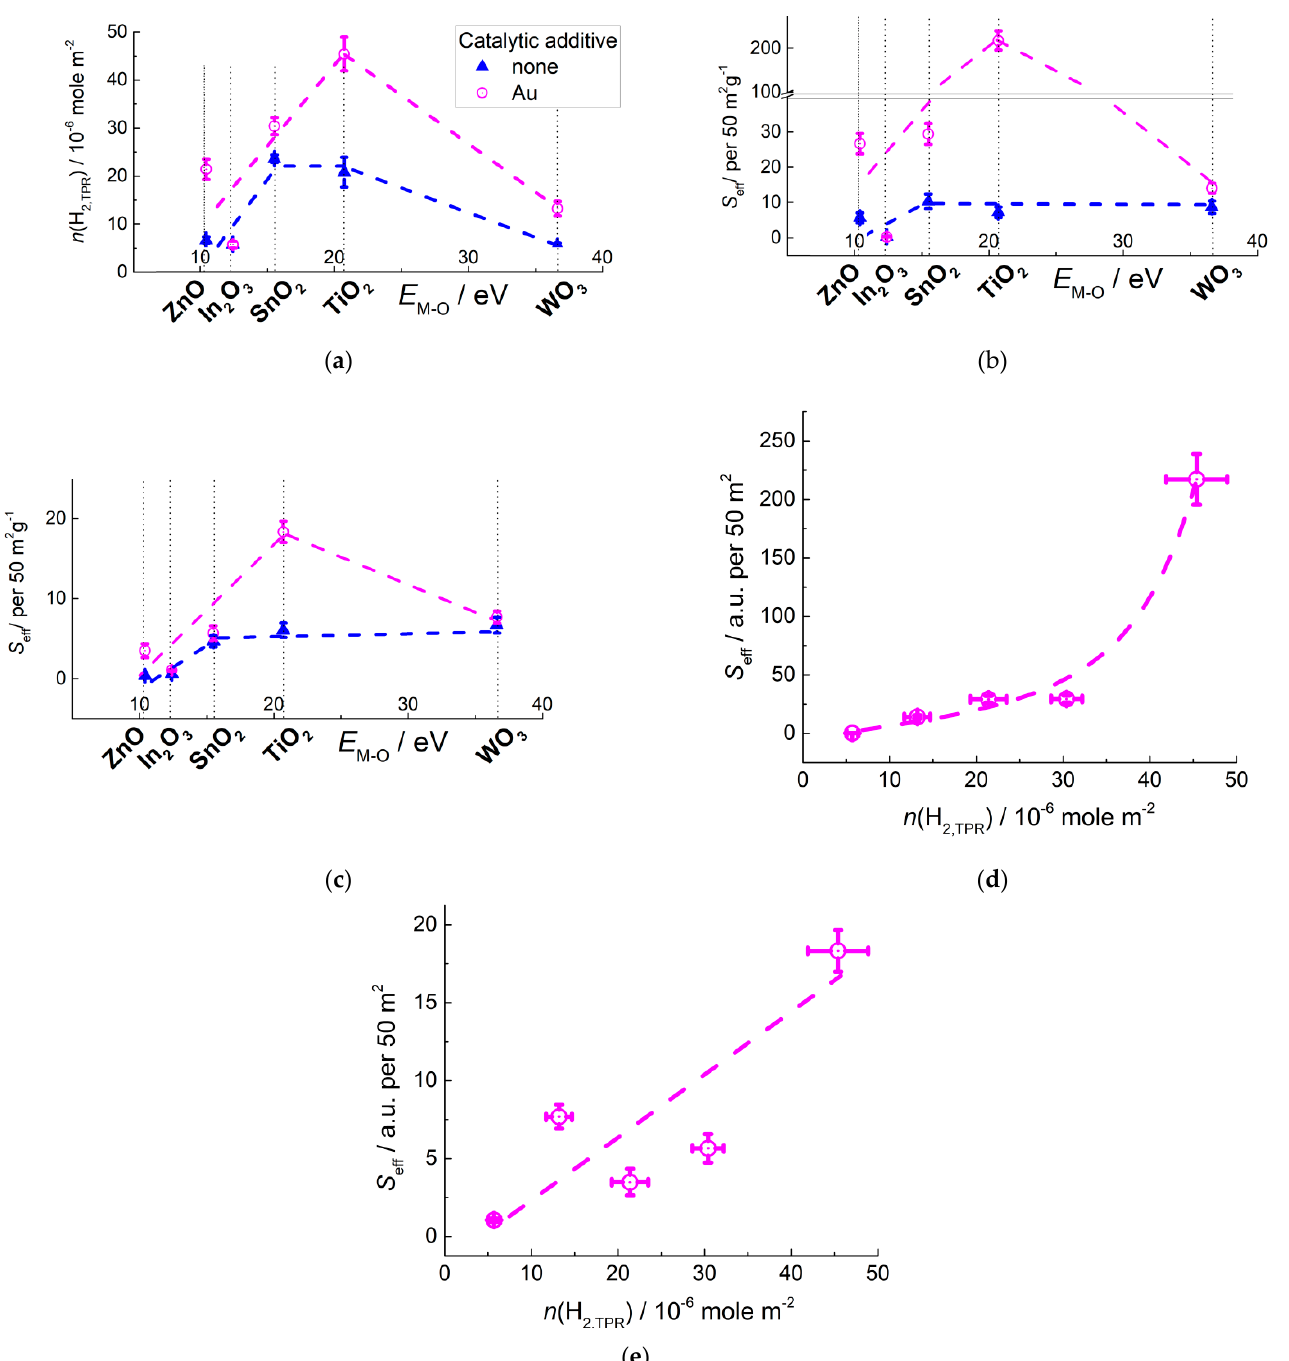
Figure 25. Concentration of oxidizing sites at the surface of pristine and Au-functionalized n -type MOS estimated from H 2 consumption in TPR at temperature below 300 ◦ C ( a ) in comparison with the sensitivity to 20 ppm of acetone ( b ) and 20 ppm of methanol ( c ) as a function of metal-oxygen bond energy in MOS. Sensitivity of Au-functionalized MOS to 20 ppm of acetone ( d ) and 20 ppm of methanol ( e ) in relation to of oxidizing sites concentration ( d , e ). Operation temperature of sensors was 250–300 ◦ C for pristine MOS and 150–225 ◦ C for Au-functionalized MOS. Adapted with permission from ref. [78]. Copyright 2021